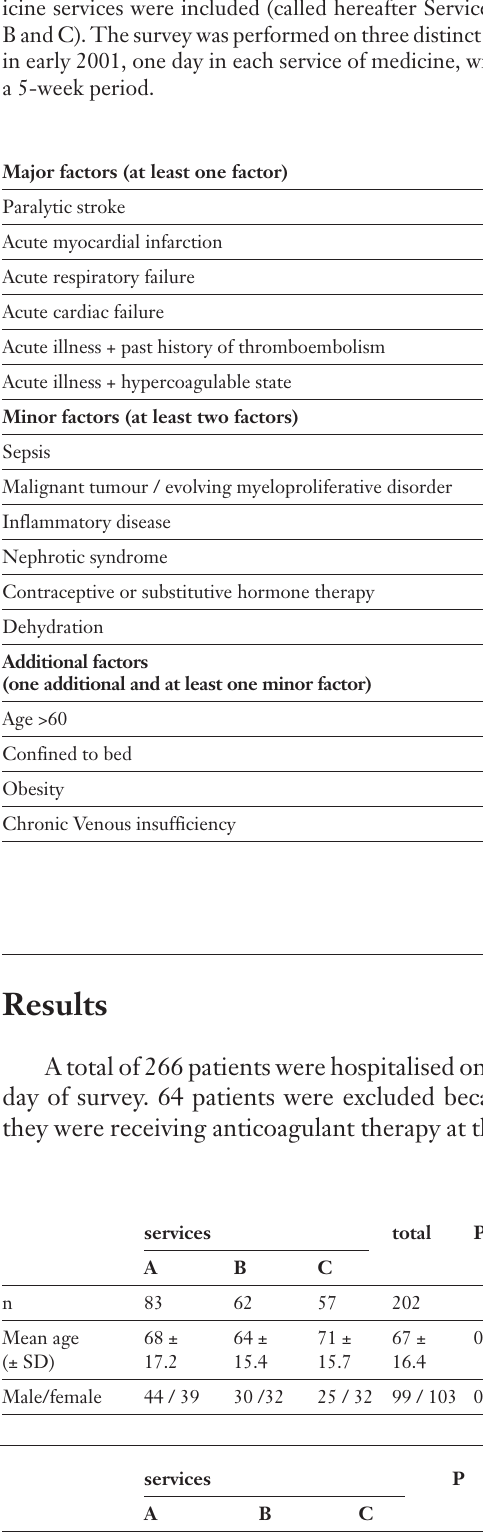
Rate of thrombopro- phylaxis according to implicit or explicit